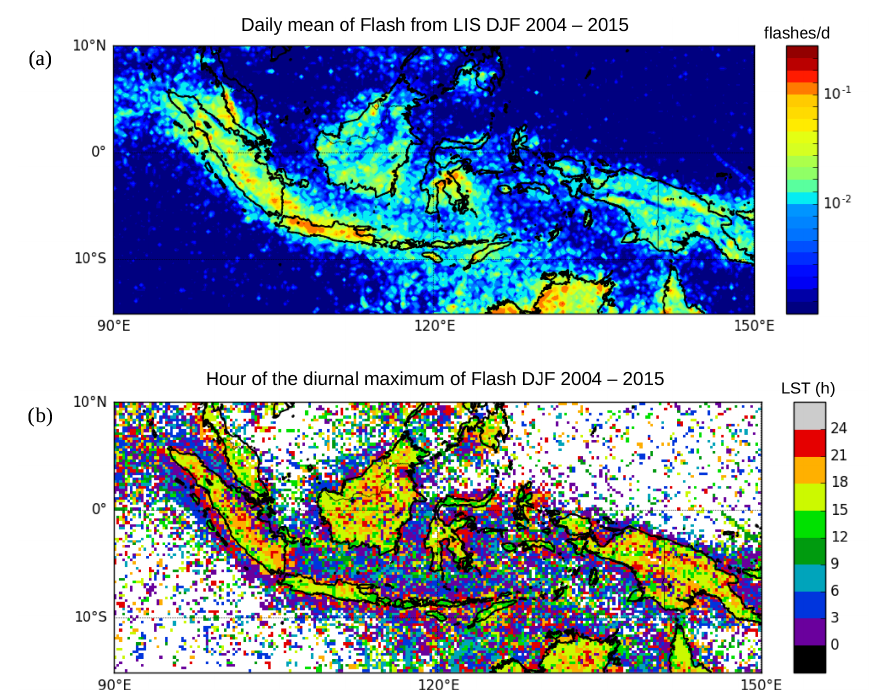
Figure 6. Daily mean of Flash measured by LIS averaged over the period DJF 2004–2015 (a) . Hour (local solar time (LST)) of the diurnal maximum of Flash (b)